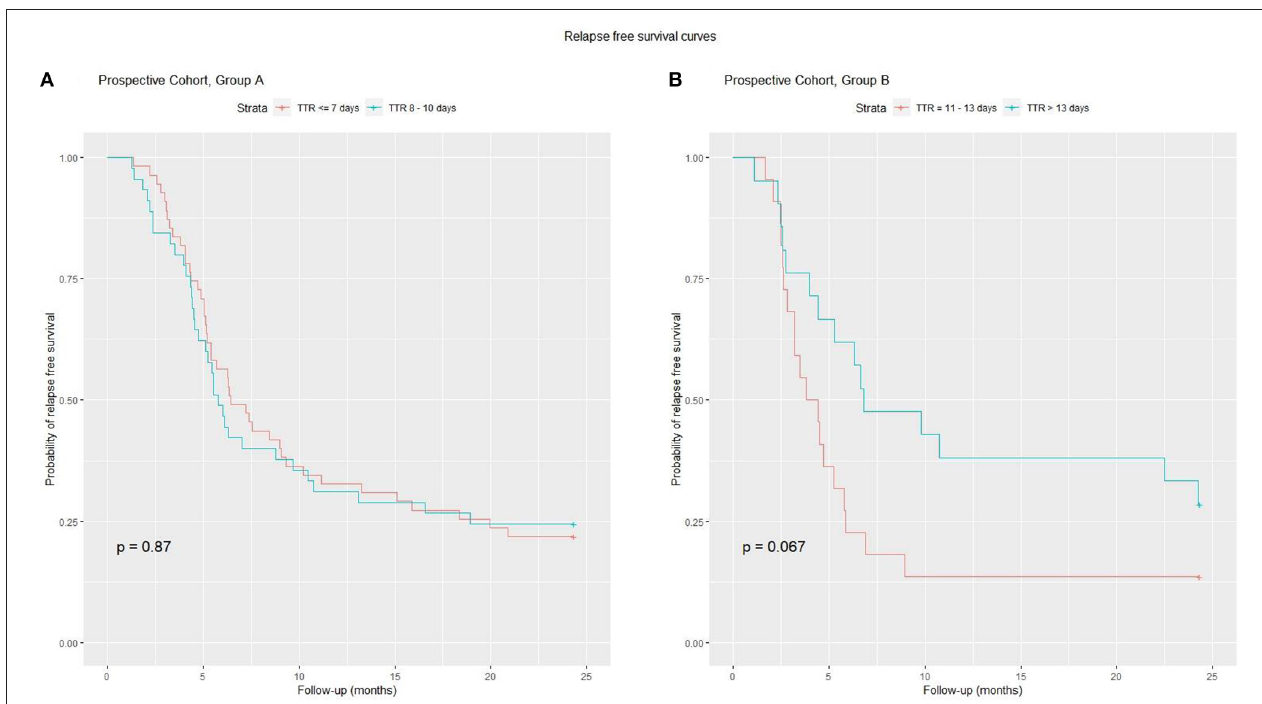
FIGURE 4 | A sub-analysis of TTR and relapse risk was performed on Group A and B. On the left (A) for Group A, the relapse-free survival curve did not differ between the two subgroups. On the right (B) for Group B patients with higher TTR have a better curve, but the difference is not significant.